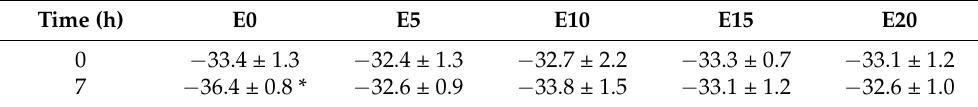
Table 1. ζ -potential of PPI emulsions at t = 0 h and t = 7 h under storage at room temperature. Results are expressed in mV. Sample name corresponds to its oil content, e.g., E0: 0% oil, E5: 5% oil, etc. * Asterisk indicates significant differences between one specific sample at t = 0 h and t = 7 h.